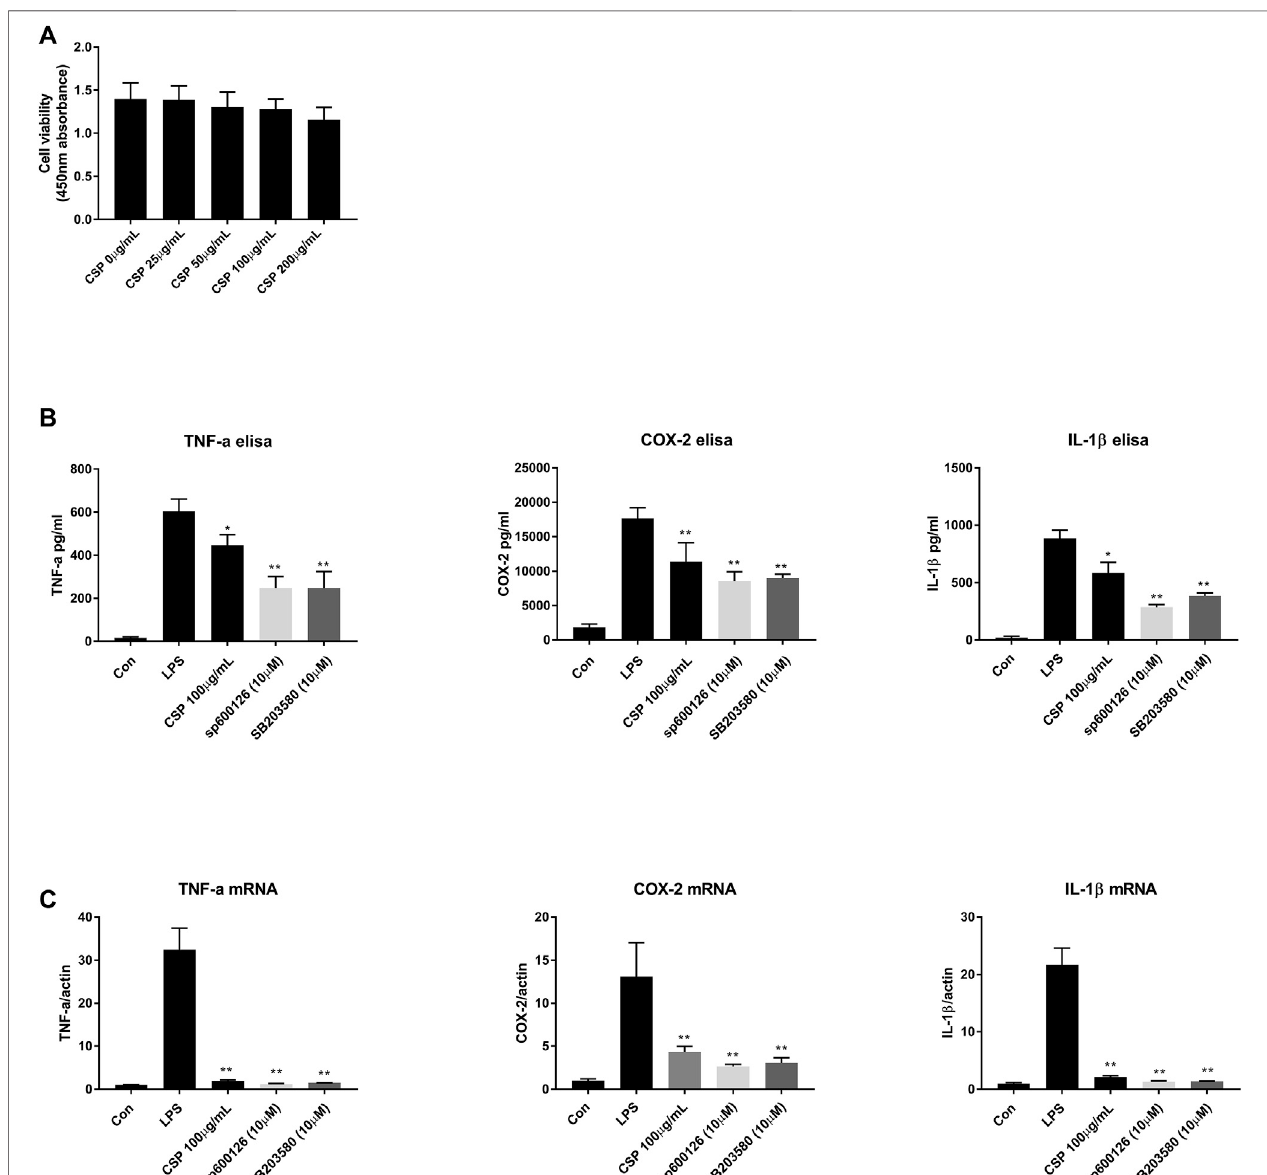
FIGURE 7 | CSP inhibited the pro-in fl ammatory cytokines in LPS-stimulated NR8383 cells. (A) Safe concentration test for CSP in NR8383 cells; (B) mRNA expression of IL-1 β , TNF- α , and COX-2 in LPS-stimulated NR8383 cells; (C) Expression of IL-1 β , TNF- α , and COX-2 in LPS-stimulated NR8383 cells. * p < 0.05, ** p < 0.01 compared with LPS